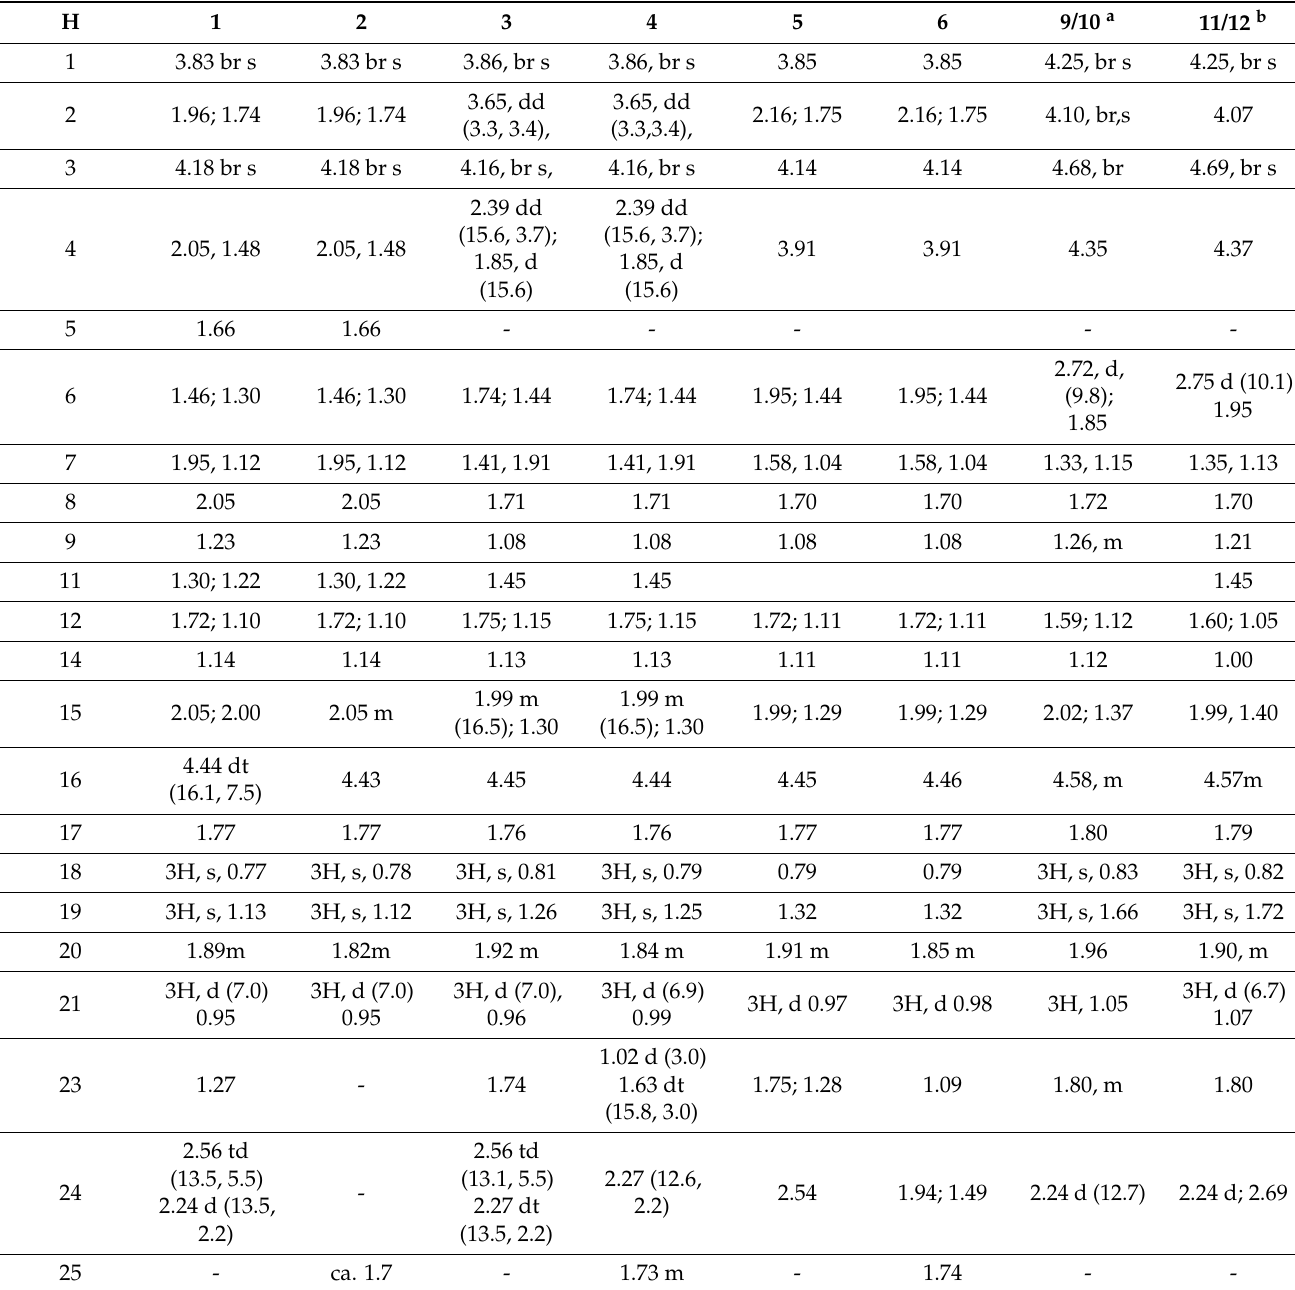
Table 1. 1 H NMR data ( δ in ppm, ref. TMS, J in Hz) for sapogenins 1 and 2 in CDCl 3 , 3 – 8 in CDCl 3 + CD 3 OD (1:1) and saponins 9 , 11 (in